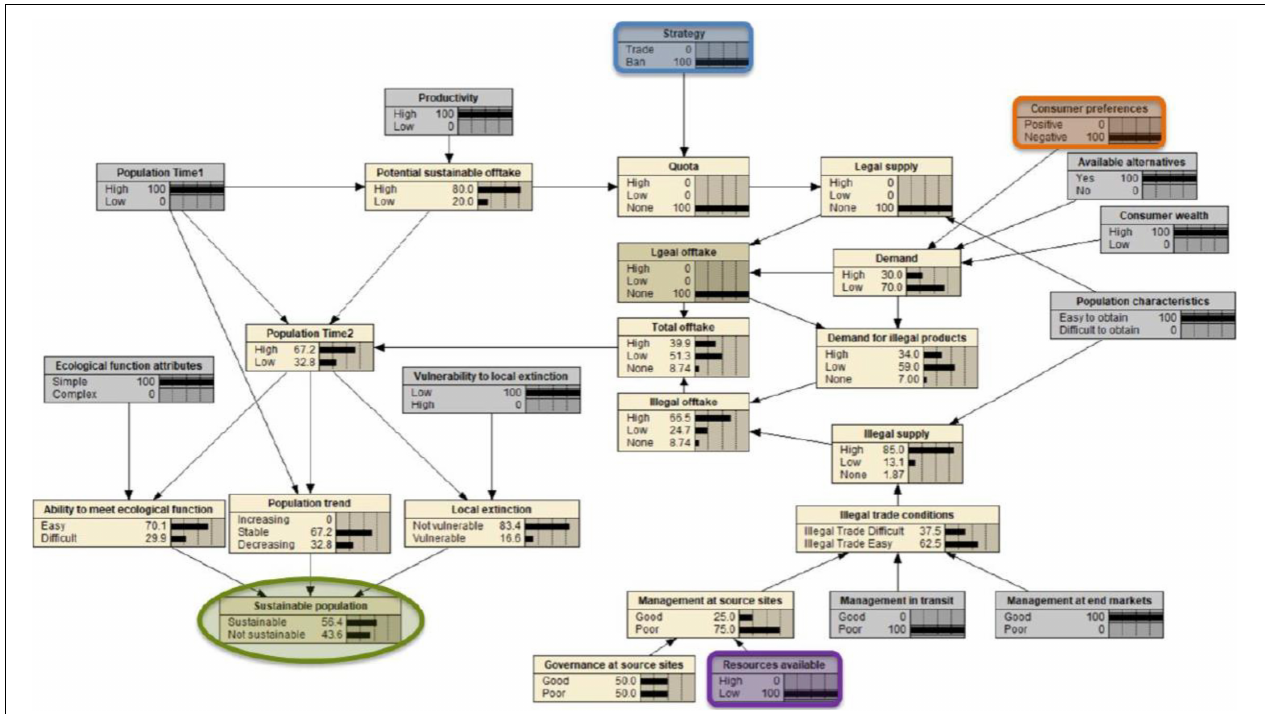
FIGURE 4 | Illustrative expanded BBN from Figure 3 with additional nodes to represent how some of the drivers of demand and management could be represented in the model. The BBN shows the (hypothetical) probability of a sustainable population for a particular species with a particular set of findings (gray boxes) under a trade ban. Gray nodes are where the state is fixed and known. Yellow nodes show calculated probabilities for each state given the fixed states of the gray nodes. This BBN is a reduced and simplified model, all nodes only have two or three discrete states, only two time periods are included, and all relationships are simple. Note that all probabilities used to construct this BBN and shown in the figure are illustrative